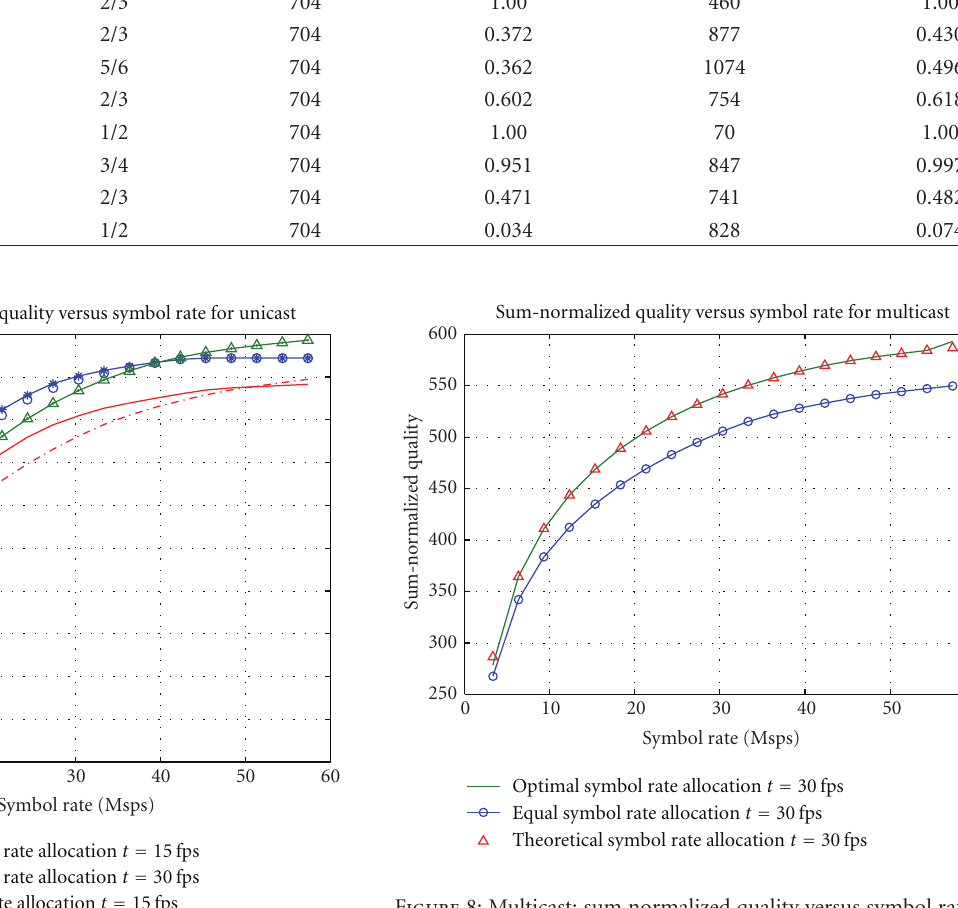
Figure 8: Multicast: sum normalized quality versus symbol rate at t = 15 and 30fps.